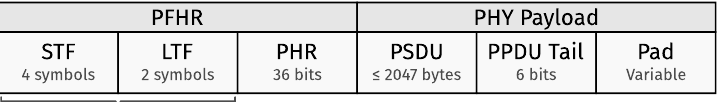
Figure 2. Format of a Smart Utility Network (SUN) Orthogonal Frequency Division Multiplexing (OFDM) physical layer (PHY) Protocol Data Unit (PPDU). Note that we define the PHY frame header (PFHR) as the combination of the synchronisation header (SHR) and PHY header